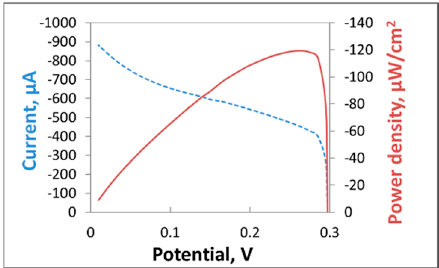
Figure 5. Polarization and power density curves of the graphite bioelectrode modified with chitosan solutions of GOx (4 mg/mL) in the presence of 20 mM glucose.